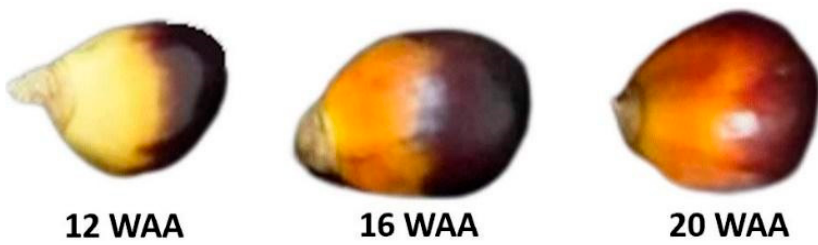
Figure 8. Different maturity stages of oil palm fruitlets indicated by different colors.